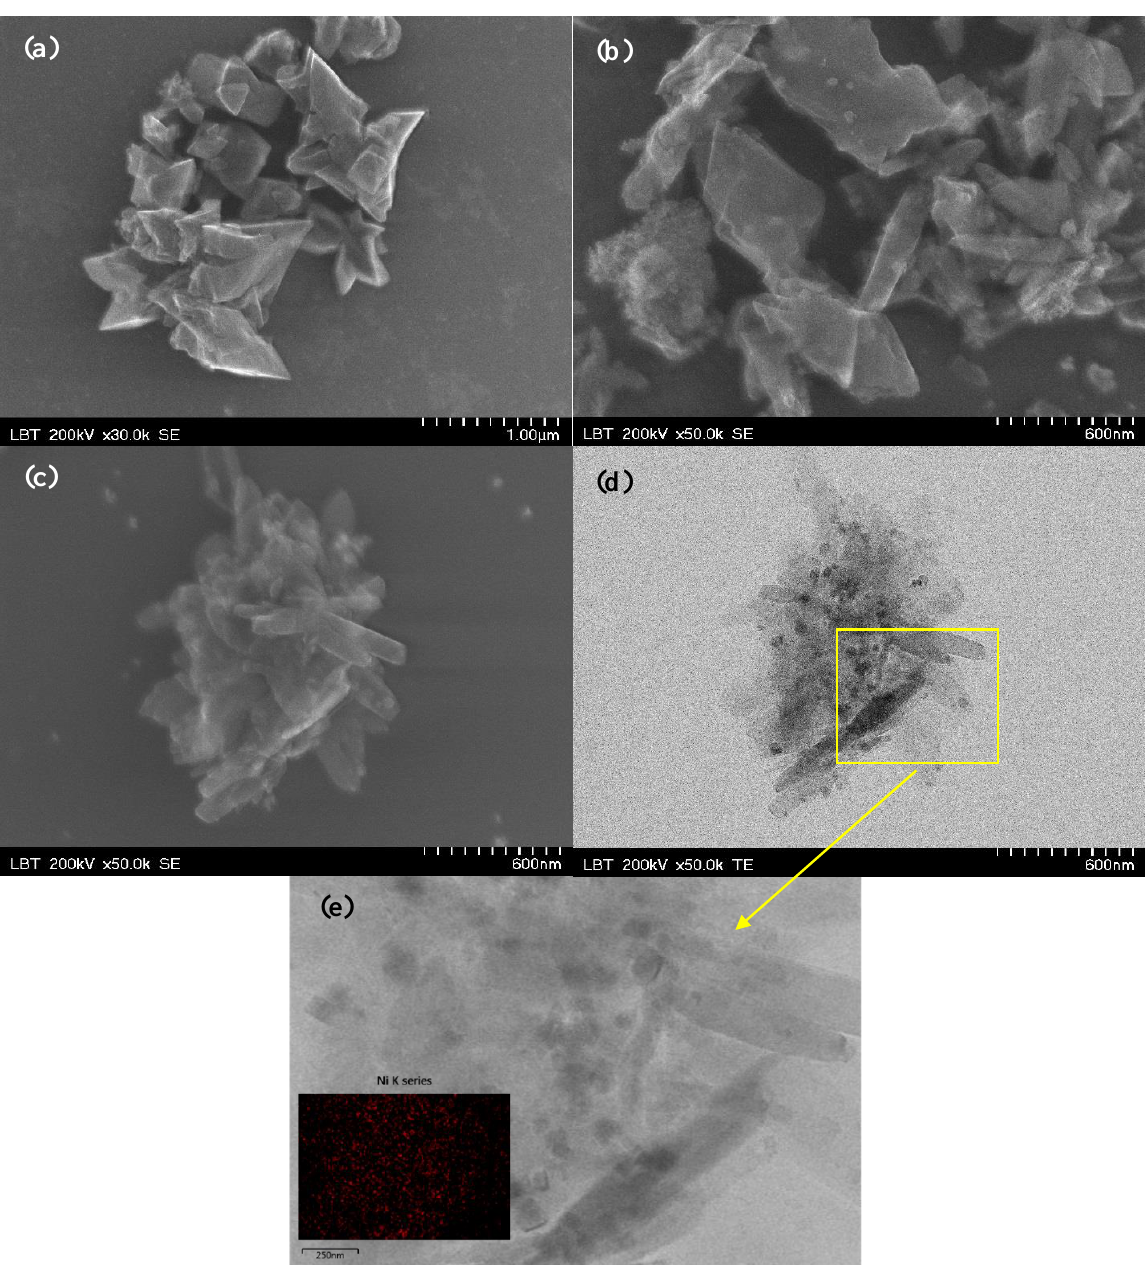
Figure 3. SEM images of ( a ) MIL-53, ( b ) MIL-53 – Al 2 O 3 , and ( c ) Ni/MIL-53 – Al 2 O 3 and TEM images of ( d ), ( e ) Ni/MIL-53 – Al 2 O 3 catalyst.